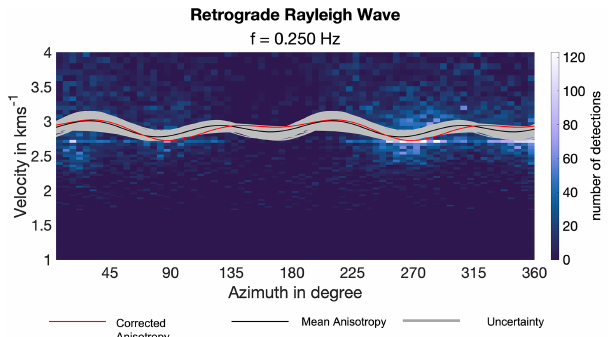
Figure 6. Histogram showing the mean anisotropy (black) of retro- grade Rayleigh waves at a frequency of 0.25Hz, with each resam- pling of the bootstrap algorithm plotted as a curve (grey) acting as an uncertainty in anisotropy and the corrected anisotropy based on synthetic wavefield